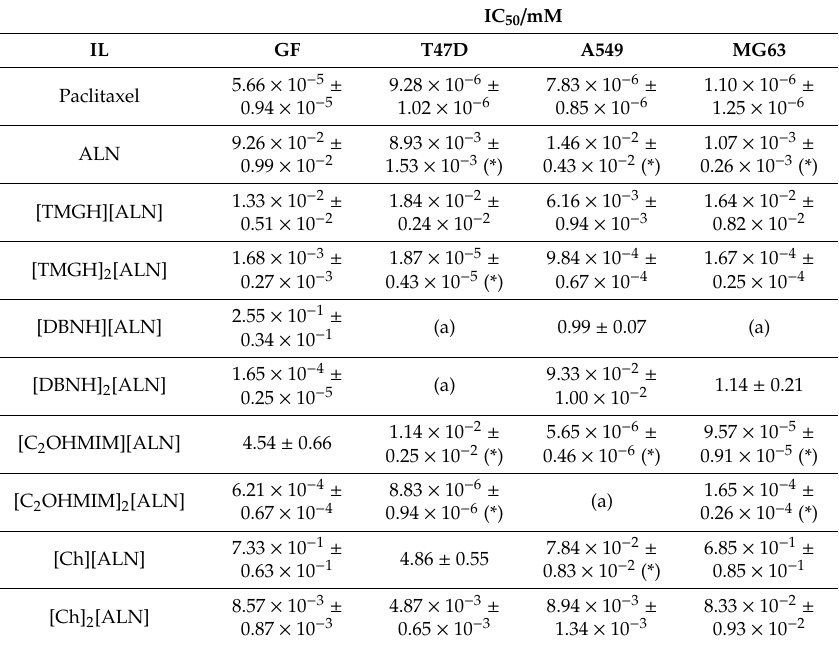
Table 3. Cytotoxicity of the ALN–OSILs on GF cells and T47D, A549 and MG63 cell lines after 72